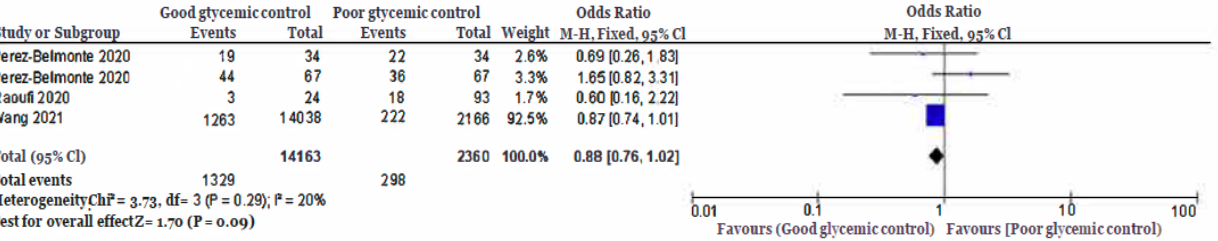
Figure 6. Forest plot for the outcome of complications in the well-controlled vs. poorly controlled glycemic comparison (calculated using a fixed-effect OR of 0.88) [29,30,31].